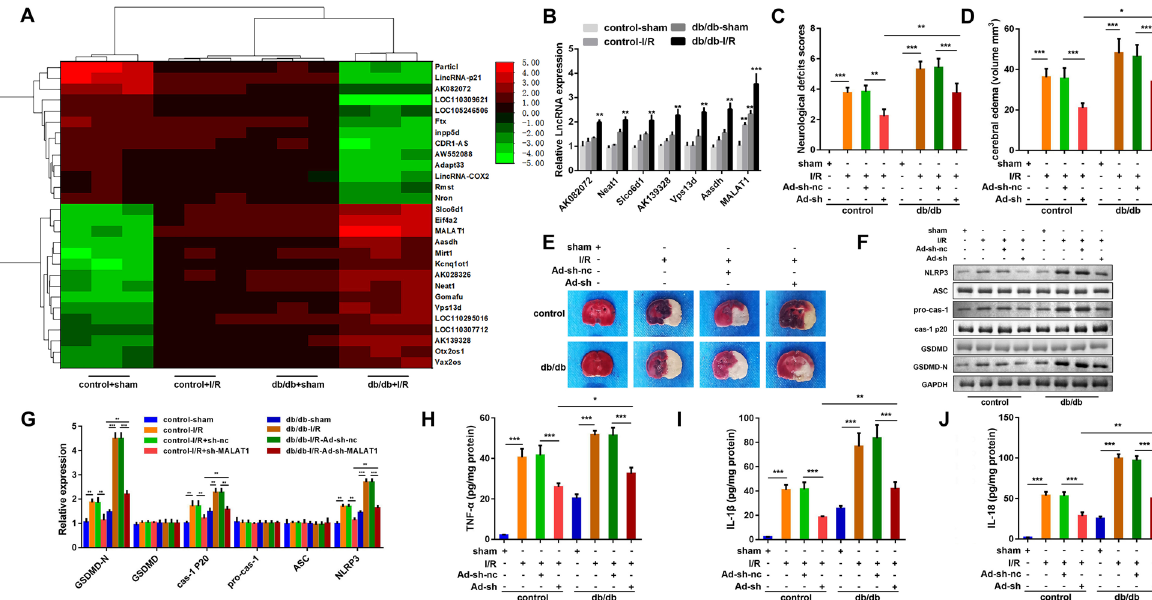
Fig. 2 Knockdown of MALAT1 ameliorated cerebral injury and pyroptosis of the diabetic I/R mice. A The aberrant expressed lncRNAs in diabetic cerebral ischemia screened by bioinformatic analysis. B The expression of lncRNAs in mouse brain tissues. C Neurological scores were assessed in the diabetic mice underwent I/R or sham operation. Adenovirus harboring MALAT-1 short hairpin RNA (ad-sh-MALAT1) was infected into the diabetic I/R mice through intraventricular injection. The assessment was performed 72 h after operation. D The brain tissues were isolated from the treated mice and sliced into 2 mm thickness after they were euthanasia. Encephaledema volume of the slides were calculated according to the formula: V A2)t/2. V: volume of encephaledema (mm 3 ); A1 and A2: front and back encephaledema area of the slides (mm 2 ); t: thickness ∑ (A1 = + of the slides (mm). E The brain tissues were stained by TTC solution. Pale area represented for encephaledema. F , G The protein expression of GSDMD-N, GSDMD, caspase-1 p20, pro-caspase-1, ASC and NLRP3 were separated by western blotting assay. The concentrations of TNF-α ( H ), IL-18 ( I ), and IL-1β ( J ) in the brain tissues were measured by ELISA kit. (n 6), ** P < 0.01, I/R, =